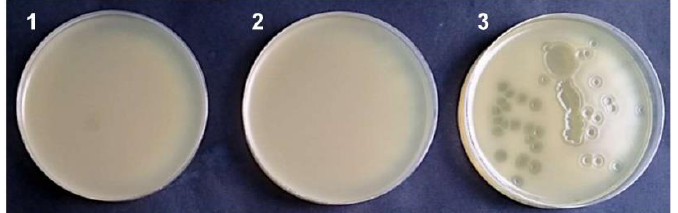
Figure 8. The effect of mixing of the reaction mixture at the stage of lysis and incubation in 80 °C on the viability of contaminating TP-84 bacteriophage. The G. stearothermophilus 10 (StrR) was mixed with 5 µL of the purified TP-84 genomic DNA. The mixture was embedded in 0.65% agar TYM broth and incubated on solid agar plates at 55 °C: 1, with host bacterium only; 2, TP-84 DNA isolated with thorough mixing, CsCl diluted 1:5; 3, TP-84 DNA isolated without mixing and CsCl diluted 1:5.